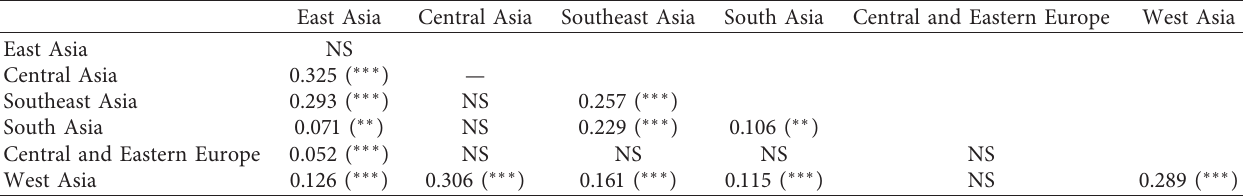
Table 10: Results of OLS regression analysis of the economic size within and between subregions.